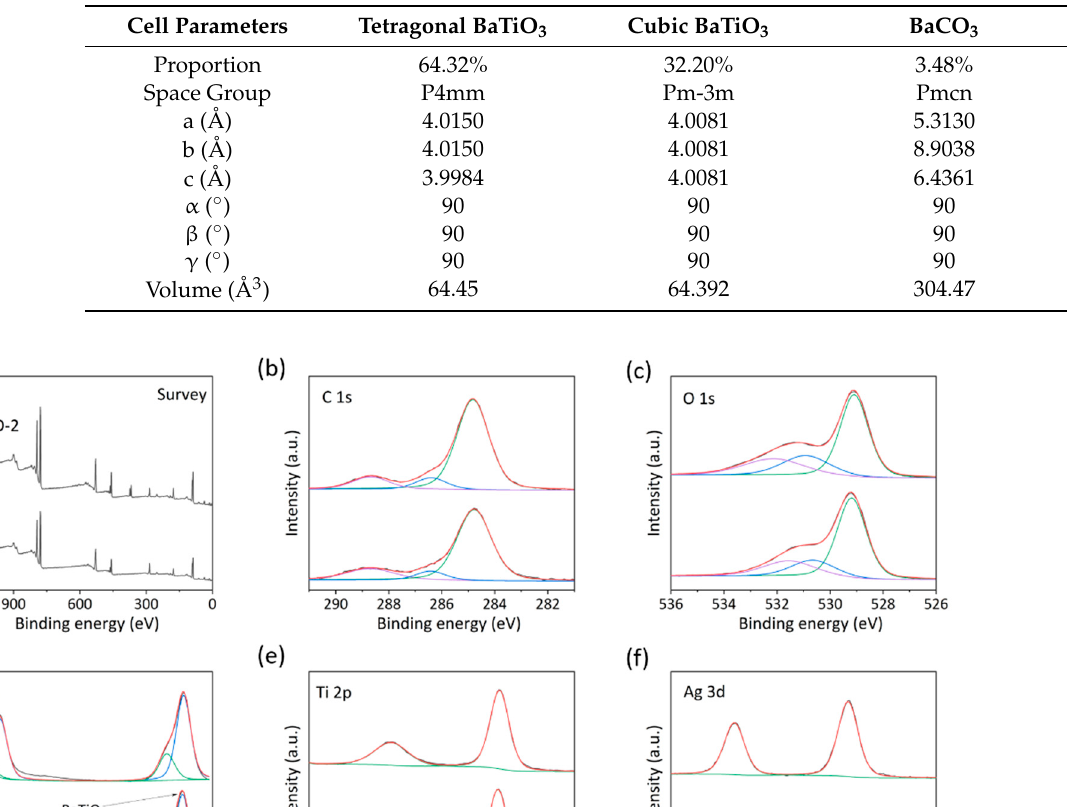
Table 1. Rietveld refined cell parameters of the synthesized BTO nanofibers.